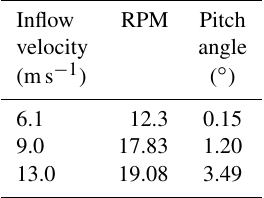
Table 2. Computed cases with uniform inflow in BEM. The first case is the one also computed with CFD. Inflow RPM